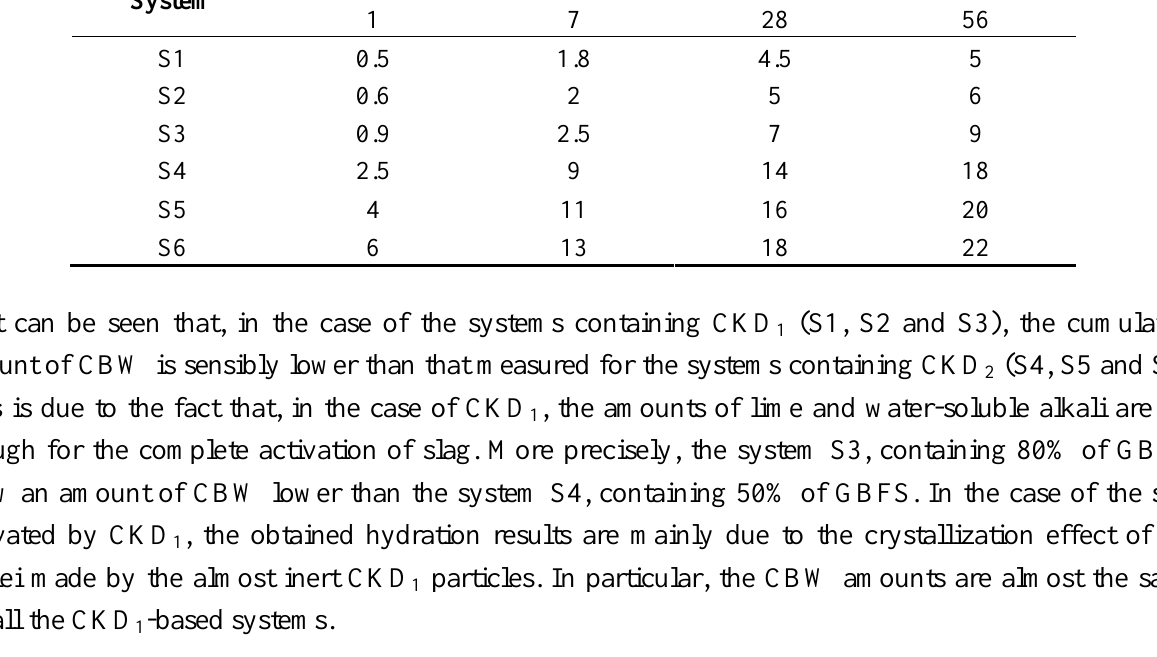
Table 5. Chemically bound water of the systems hydrated for 1, 7, 28 and 56 days (wt %). Curing time System